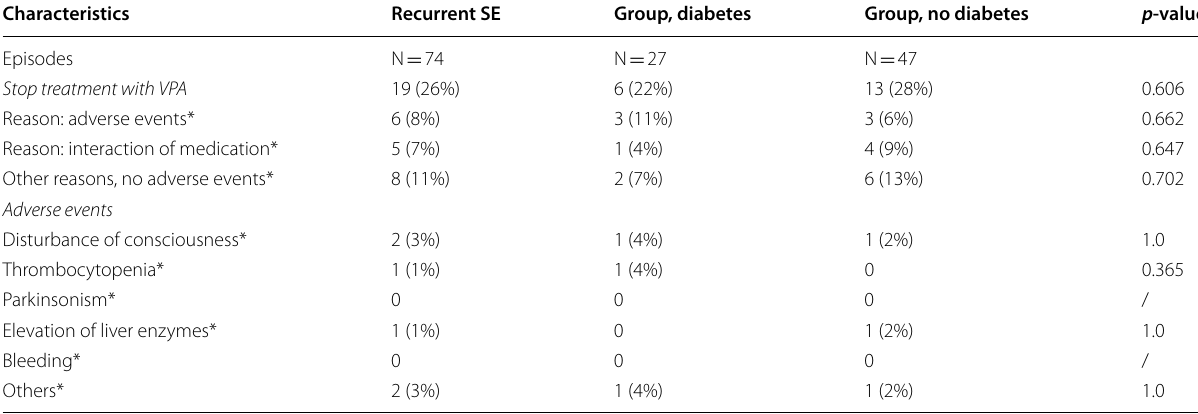
In another SE episode VPA was stopped due to an aggravation of a pre-existing thrombocytopenia Categorial variables were described with number and percentage. Proportions were compared using Pearson´s Chi2 test or Fisher´s exact test (*). Statistically significant values ( p < 0.05) are expressed in